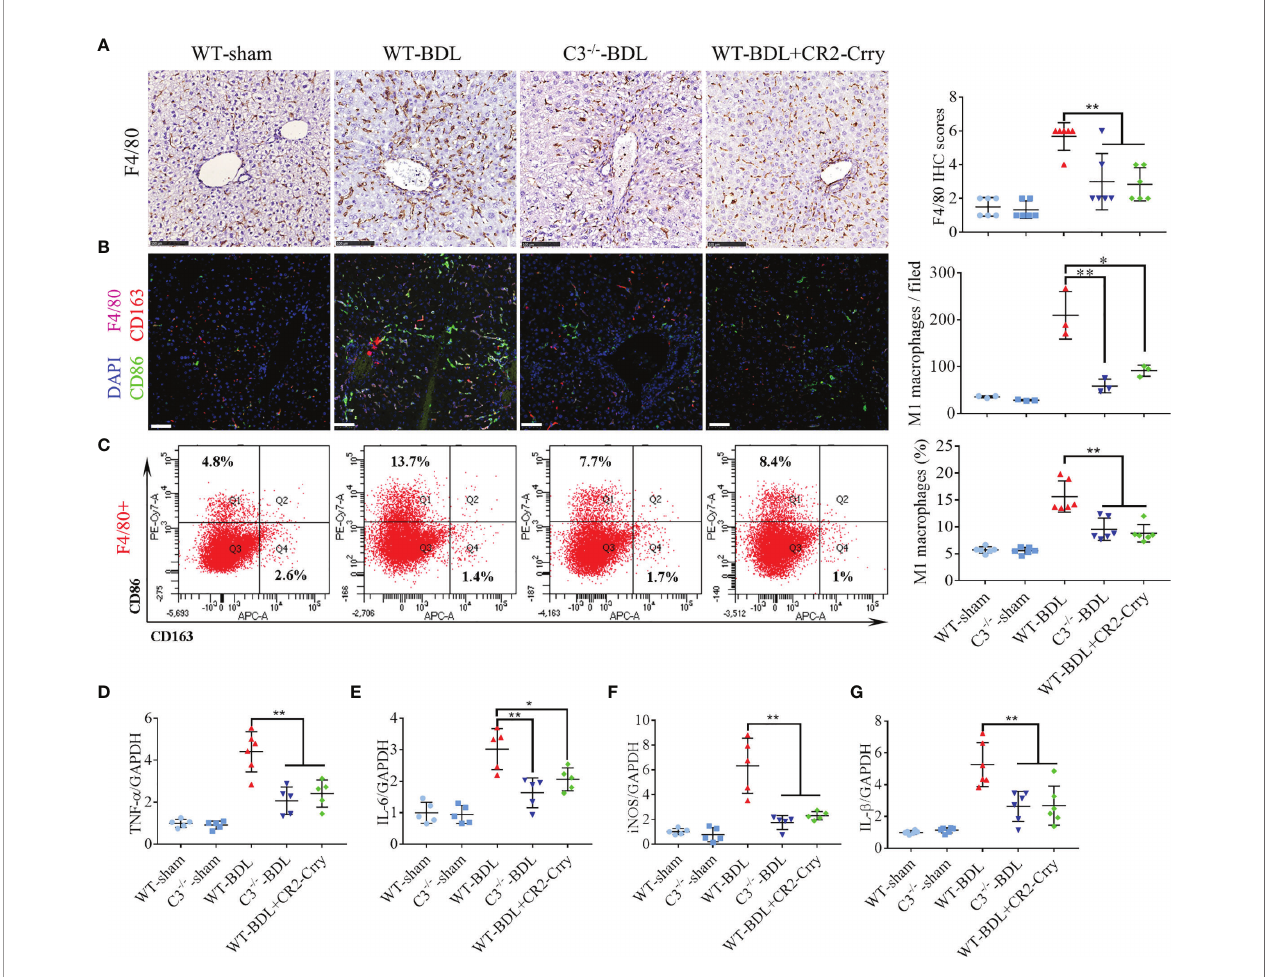
FIGURE 4 | C3 de fi ciency or CR2-Crry signi fi cantly inhibits macrophage in fi ltration and M1 polarization in mice with CLI. Wild-type and C3 de fi cient mice were subjected to BDL or sham operations. WT-BDL mice were injected i.p. with PBS or CR2-Crry and sacri fi ced 3 days later. (A) F4/80 immunostaining (n = 6 per group; scale bars, 100 m m). (B) Immuno fl uorescence test for M1 macrophages (n = 3 per group; scale bars, 50 m m). (C) Flow cytometry analysis for M1 macrophages (n = 6 per group). (D – G) qRT-PCR measurements of (D) TNF- a , (E) IL-6, (F) iNOS and (G) IL-1 b mRNA levels (n = 5-6 per group). Results are expressed as mean ± SD. *p < 0.05, **p <